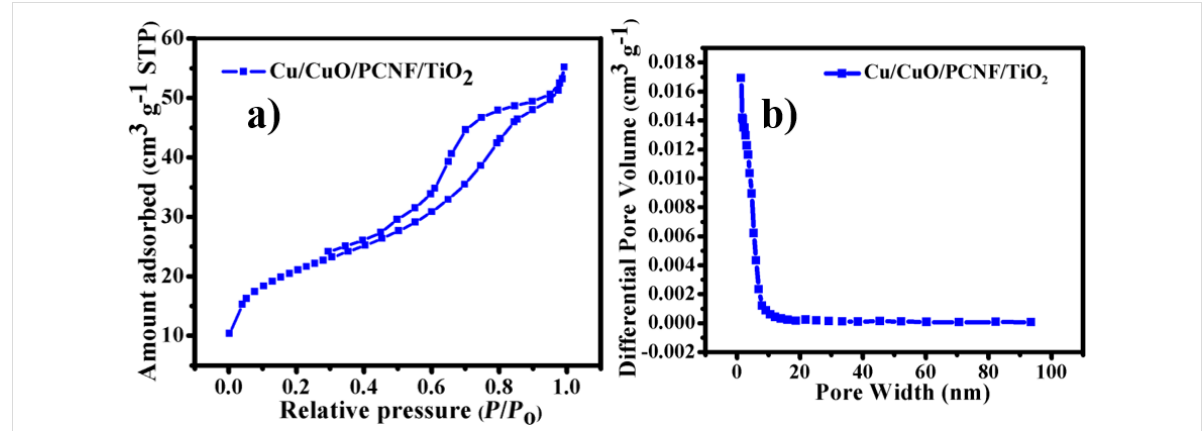
Figure 7: (a) N 2 adsorption–desorption isotherms of the Cu/CuO/PCNF/TiO 2 composite at 77 K and the (b) differential pore volume of the Cu/CuO/ PCNF/TiO 2 composite as a function of the pore diameter.